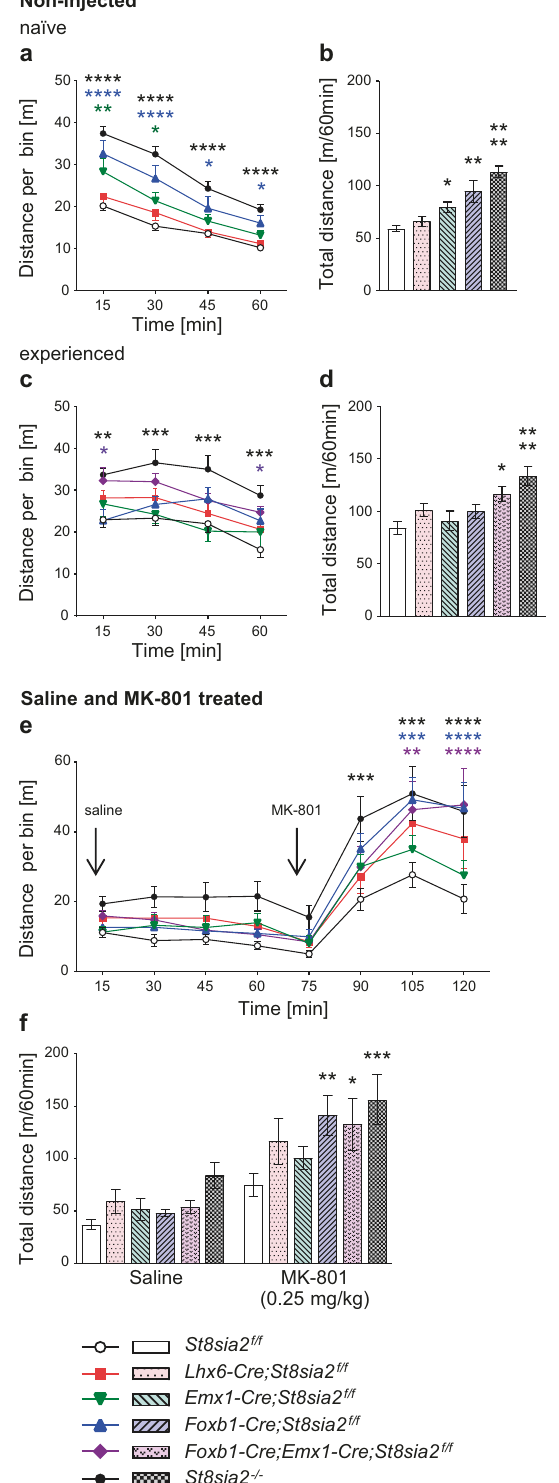
task with 60 s, but not with 10 s of forced delay yielded signi fi cant effects in a study on working memory de fi cits caused by optogenetic manipulations of thalamo – prefrontal circuit function [45]. For the testing with 15 s delay, performance of all but the St8sia2 − / − group increased above chance level on day 2, resulting in a signi fi cant main effect of day, with no effect of genotype